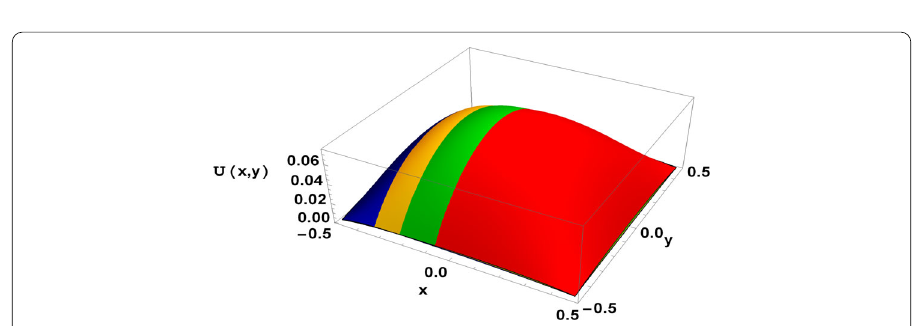
Figure 7 Three-dimensional graph for the velocity profile with various Hartmann number values